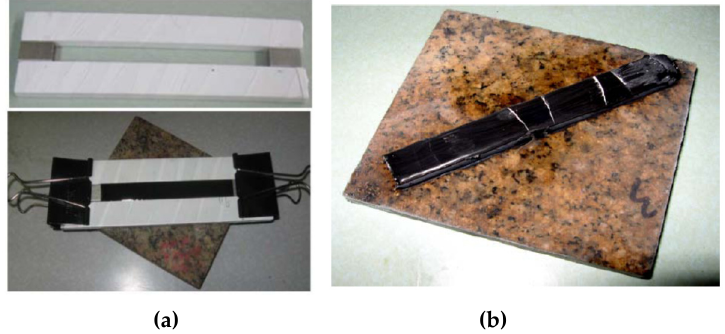
Figure 4. Fabrication of binder test samples: ( a ) top: molds for fabricating binder test samples; bottom: completed binder test sample in the mold; ( b ) typical visible crack patterns in asphalt binder test sample after AE testing. The binder samples have the same nominal dimensions as the specimens in the Bending Beam Rheometer (BBR) test (125 mm long, 12 mm wide, and 6 mm thick). The binder is poured into the mold seating on the granite (which has been heated to 135 °C) to assure good adhesion between the binder sample and the granite substrate.